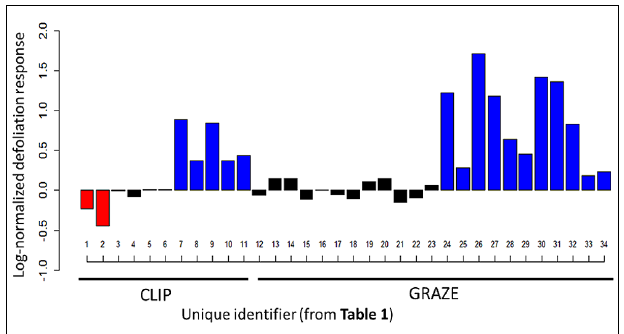
FIGURE 4 | Log-normal change in foliar silica content of defoliated grasses identified in the literature review. Blue bars indicate a ≥ 20% increase in silica following defoliation, red bars indicate a ≥ 20% decrease, and black bars indicate < 20% change in either direction. Individual responses are arranged according to unique identifiers from Supplemenatry Table S2 ; Unique identifiers 1–11 represent clipping studies, and 12–34 represent grazing